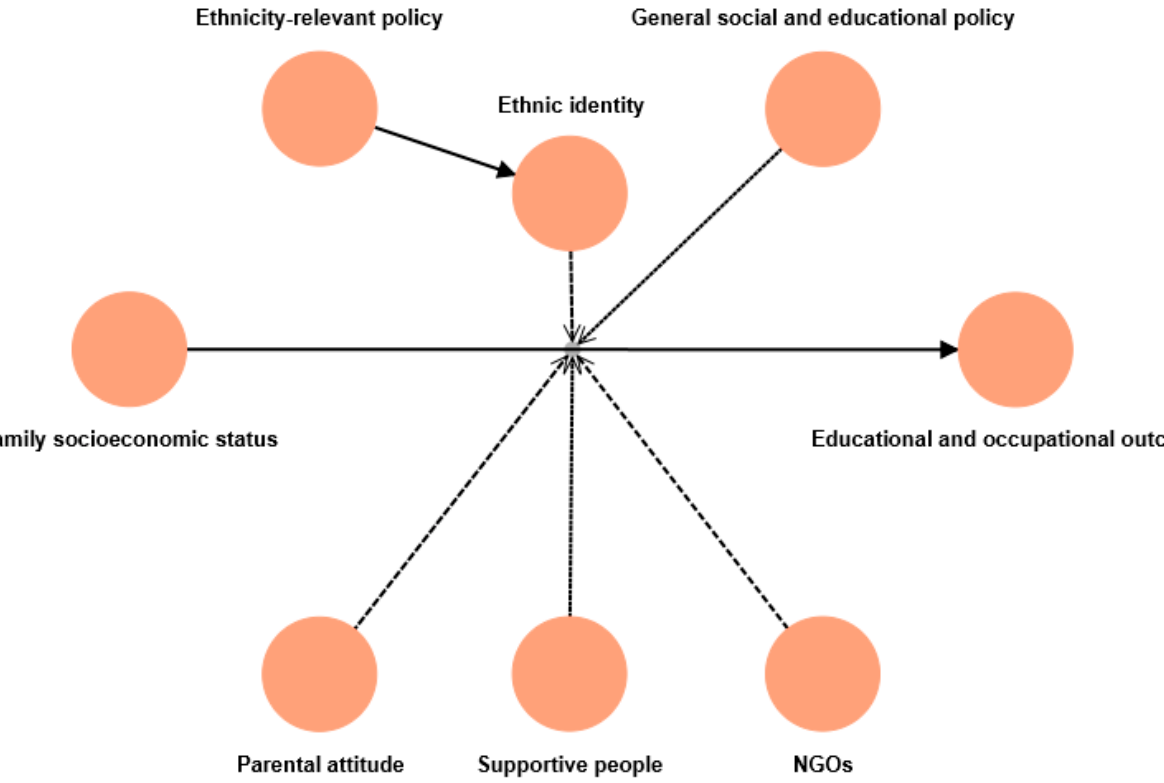
Figure 1. A model of the social mobility trajectory of children of new immigrants.